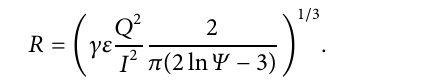
, direction. In the top-view the pink trails and the arrows indicate 𝑦 𝑥